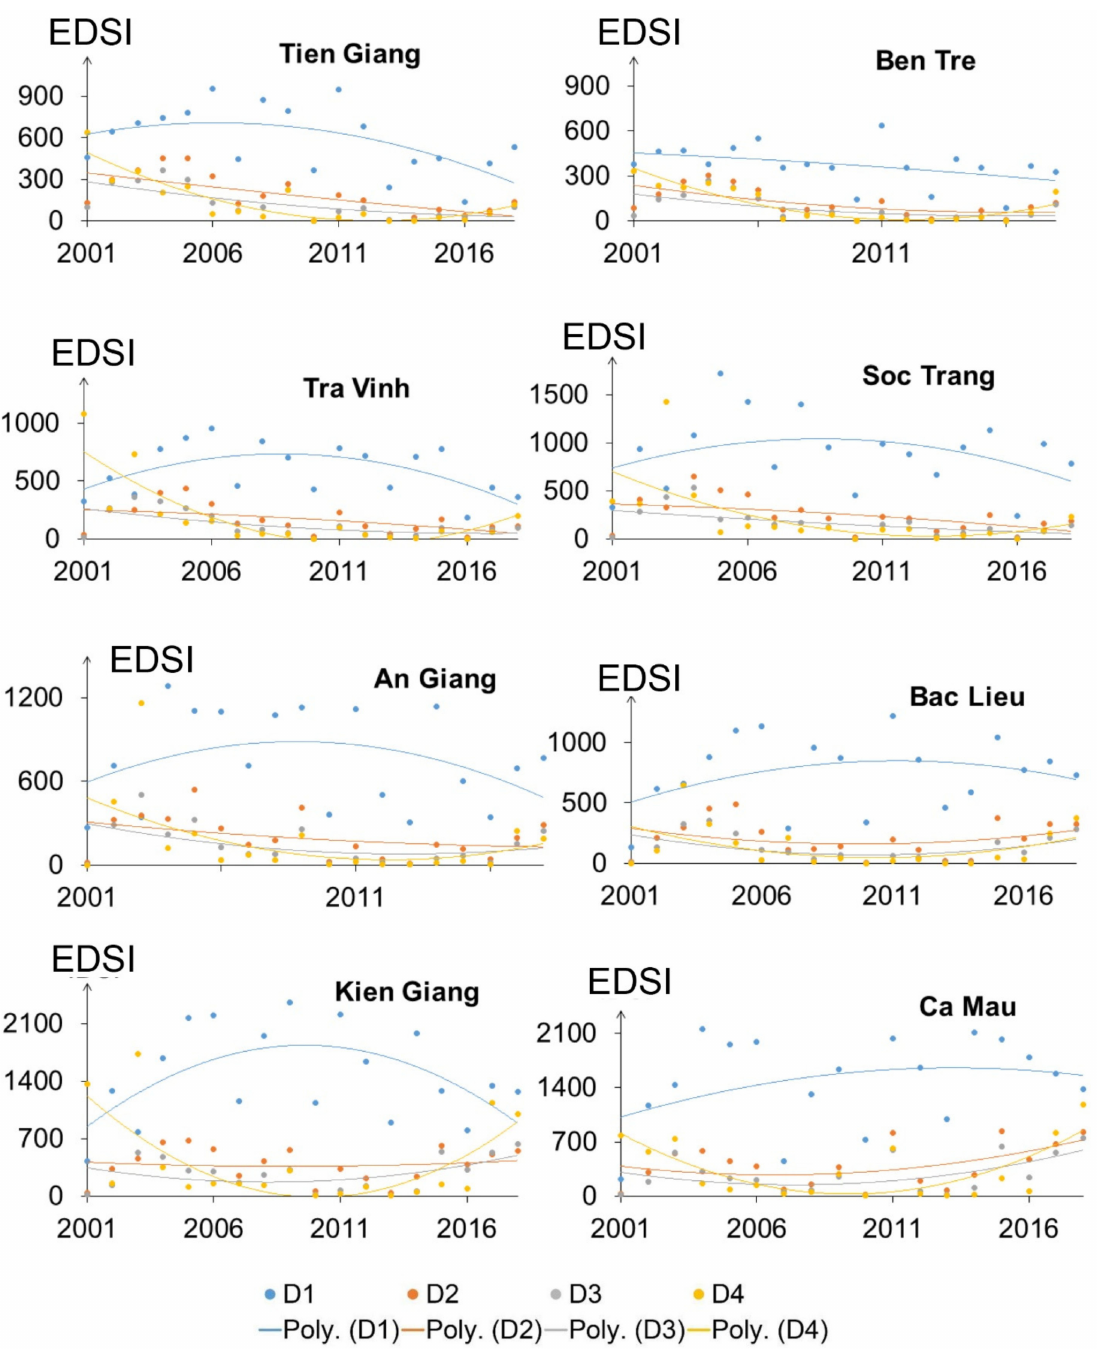
Figure 7. Variations in drought levels in di ff erent provinces during the 2001–2018 period. The points show the real values in each province and the lines are the polynomial fitting of these points respectively, for each drought